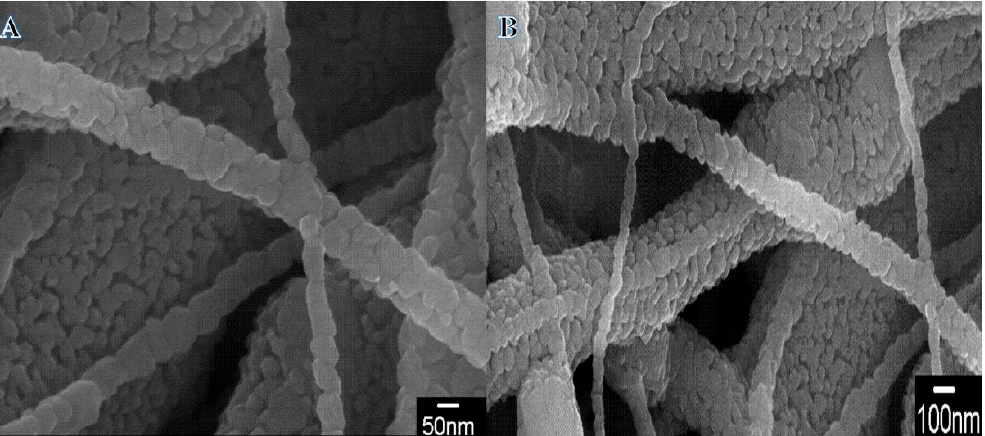
Figure 1. Low and high magnification FE-SEM images of the produced powder after hydrothermal process.